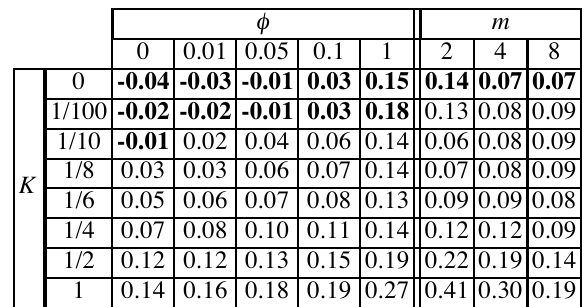
Table 6. Influence of the update method in the PD game.